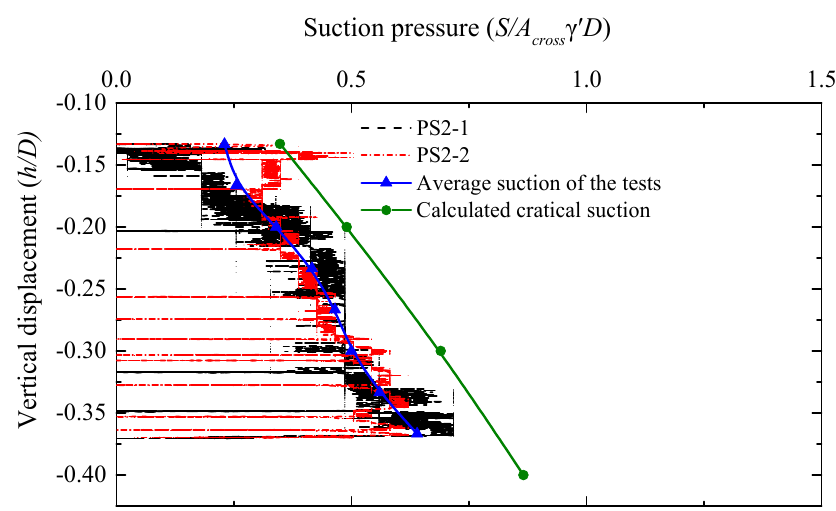
Figure 16. Relationship between the critical suction and penetration depth.